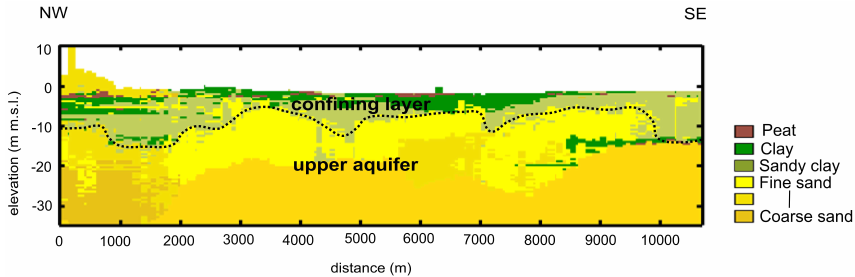
Fig. 3. A NW-SE lithological cross-section of the island of Schouwen-Duivenland (see Fig. 4 for location of cross-section). The cross-section is derived from a detailed 3-D geological model of Zeeland based on 5 drillings per 1km 2 that were classified into geological units (GeoTOP, Stafleu et al., 2011).